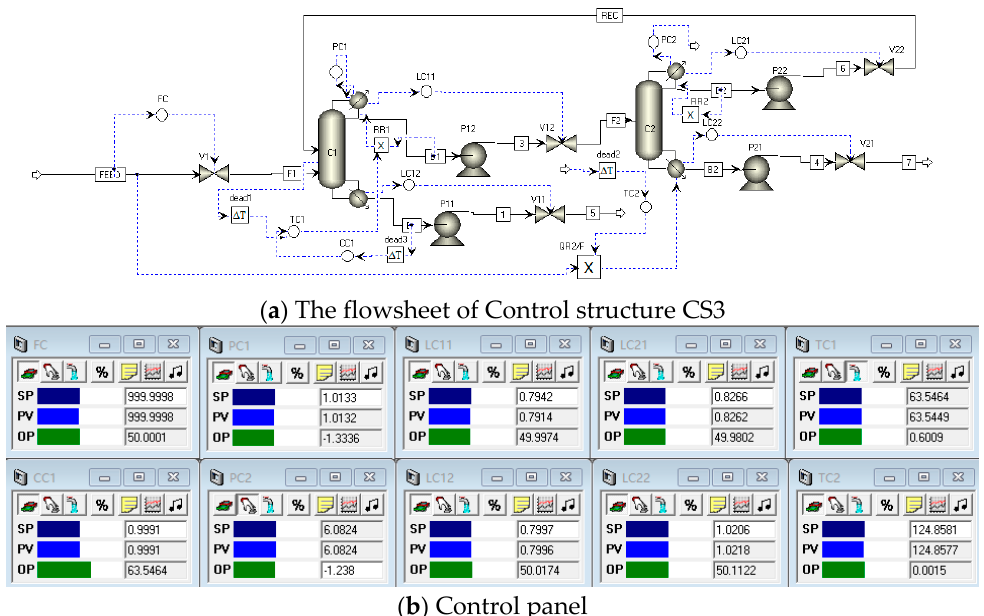
Figure 20. Control structure CS3 of flowsheet and control panel.